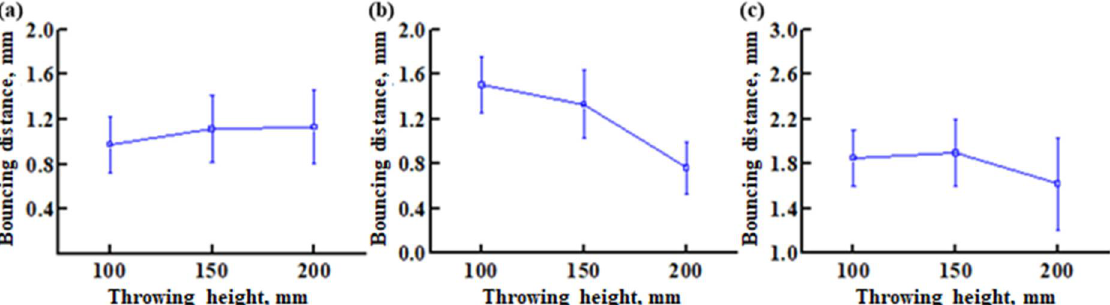
Figure 9. The relationship between bounce distance and throwing height for ( a ) SN42 ( b ) JD17 and ( c ) ZD39.